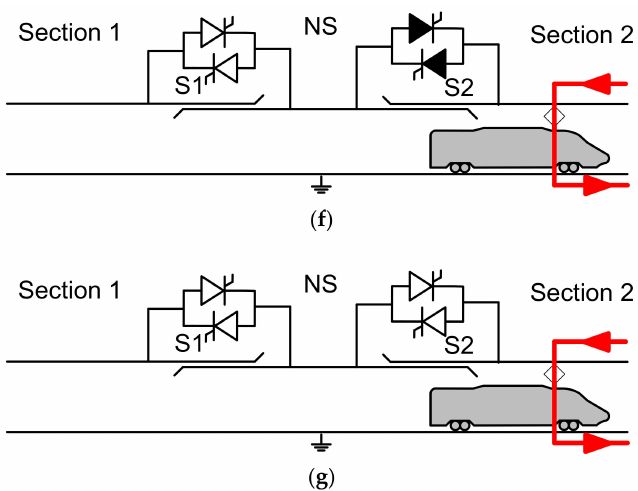
Figure 3. Current flow during transition states when a train runs through the neutral section from